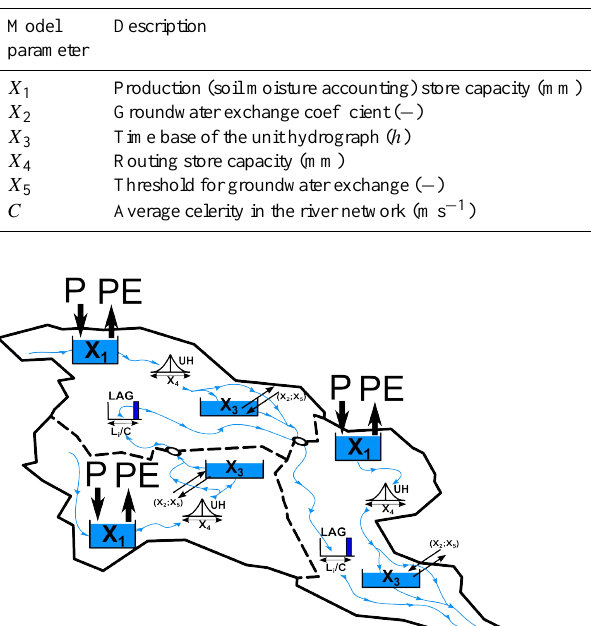
Table 2. List of the parameters for the semidistributed version of the conceptual rainfall–runoff GR5H model.